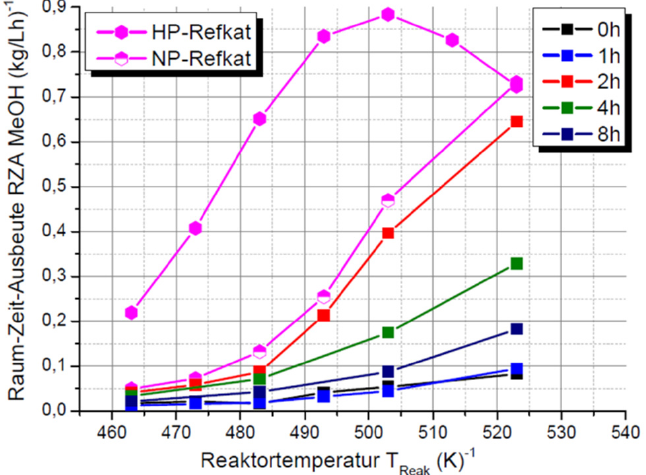
Figure 12. Space time yield MeOH depending on the reactor temperature and the duration of the calcination. Catalyst system: Cu 0.61 Zn 0.21 Al 0.18 , h equ = 600 T calc = 873 K. Catalytic tests: p = 5 MPa, GHSV = 4000 h − 1 , S = 2, Feed = 22 vol% H 2 , 62 vol% CO, 6 vol% CO 2 , 10 vol% Ar.